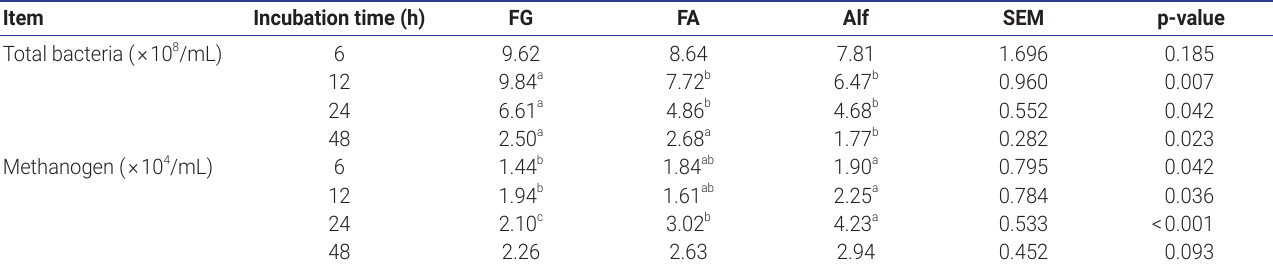
Table 7. 16S rRNA gene copy numbers of total bacteria and methanogen archaea in the whole culture of in vitro ruminal incubation of mature for- ages